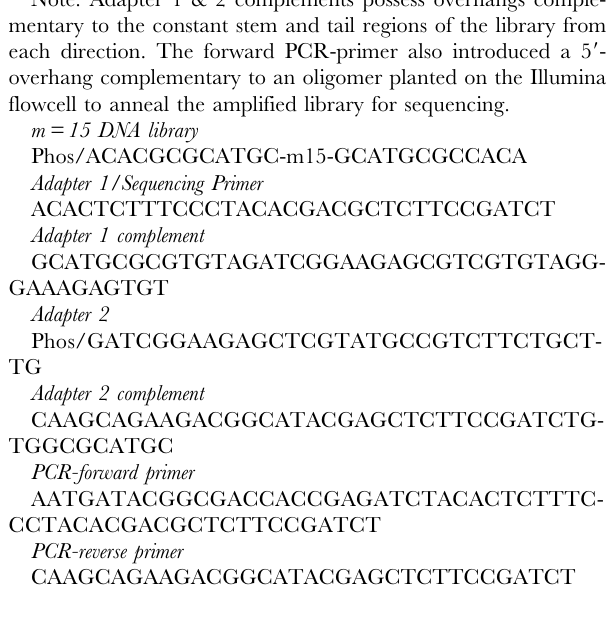
Figure S1 Detailed experimental outline. A .